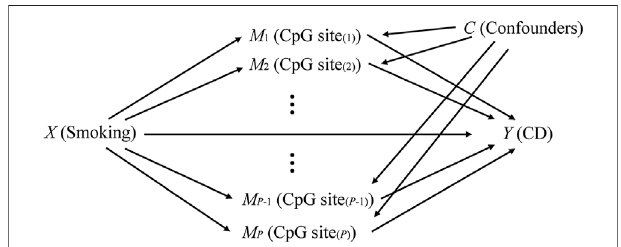
FIGURE 1 | The causal diagram with high-dimensional